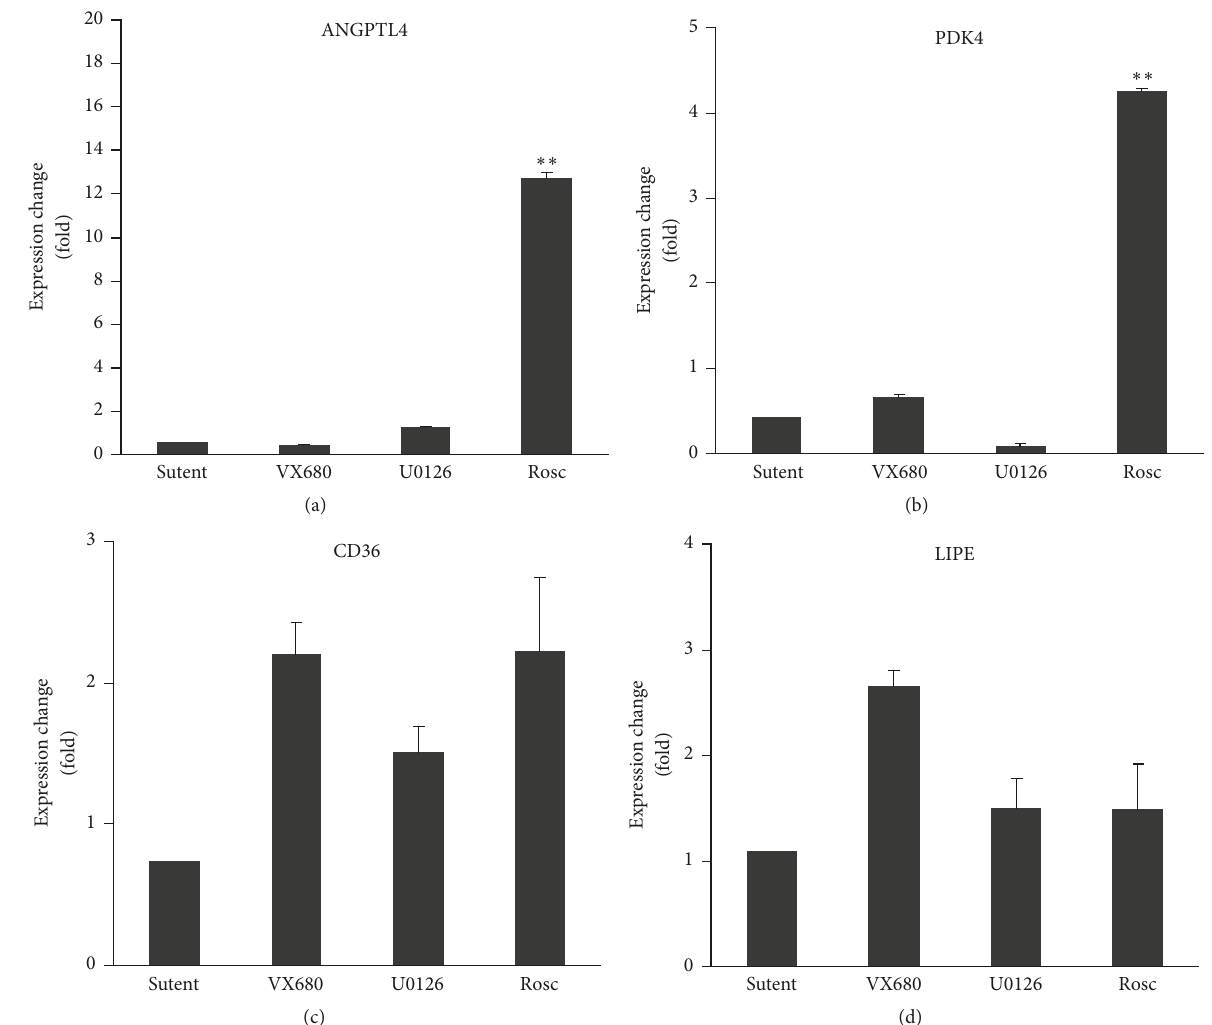
Figure 5: Increased ANGPTL4 and PDK4 expressions are associated with inhibition of TNF 𝛼 -induced and CDK5-mediated phosphorylation ofPPAR 𝛾 .HPA-vcellswereincubatedwithdifferentproteinkinases(i.e.,VEGFRandPDGFRinhibitorSutent(1 𝜇 M),AURKA/B/Cinhibitor VX680 (0.1 𝜇 M), MEK1/2 inhibitor U0126 (1 𝜇 M), and CDK5 inhibitor roscovitine (Rosc, 10 𝜇 M) or vehicle control (0.1% (vol/vol) DMSO) in the presence of TNF 𝛼 (5ng/ml) for 24 hours. Total RNA was extracted and subjected to real-time RT-PCR as described in Materials and Methods . Data represent the average and standard deviation of three independent experiments. ∗∗ represents statistically significant differences in expression induction by roscovitine compared to all other inhibitors ( 𝑝 < 0.01